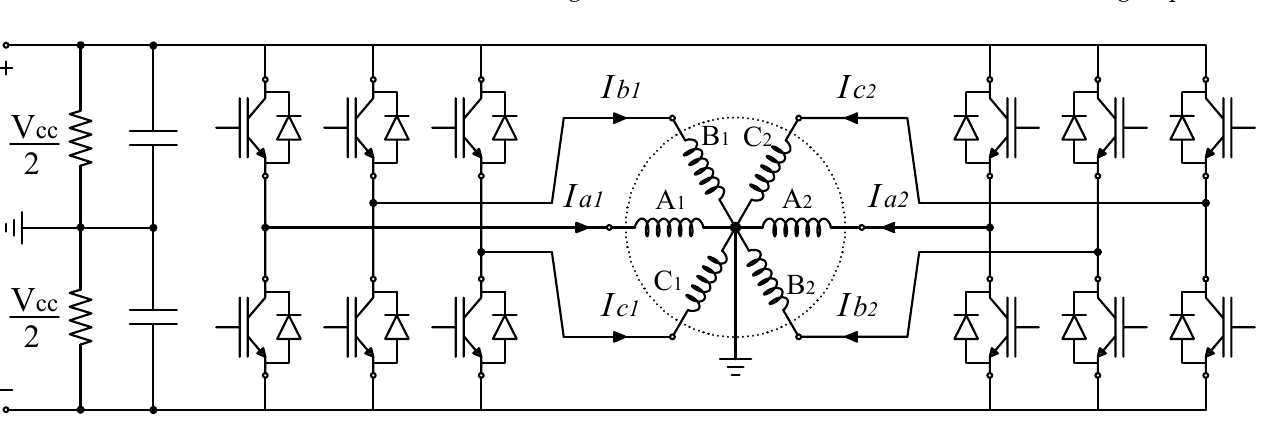
Figure 3. Conventional drive